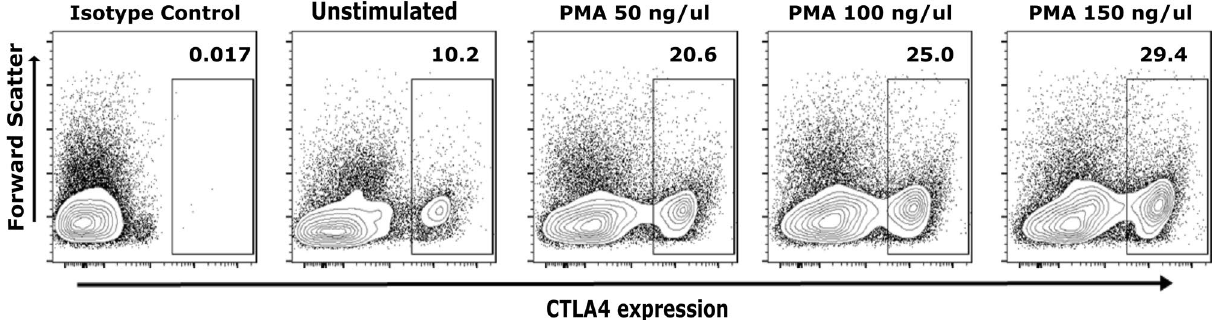
Figure 5. cHcAb6 binds to native CTLA4 on cPBMCs. CPBMCs were stimulated with PMA and Ionomycin for 8 h. Activated and control PBMCs were stained with cHcAb6 and analyzed by flow cytometry using anti-canine